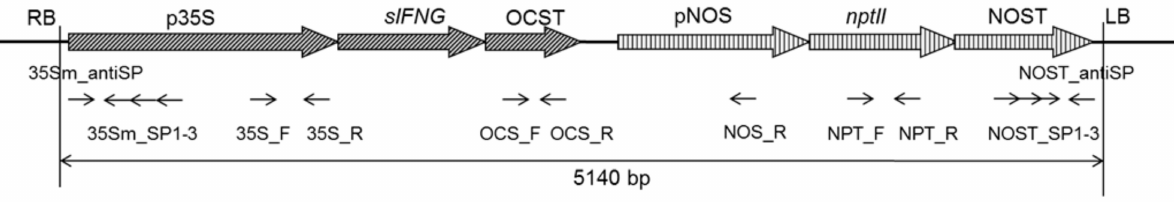
Figure 3. The structure of T-DNA from plasmid pART27-INT6 and primers binding sites. p35S—35S promoter; sIFNG—synthetic bovine gamma interferon gene; OCST—octopine synthase termina- tor; pNOS—nopaline synthase promoter; nptII—neomycin phosphotransferase II gene (kanamycin resistance); NOST—nopaline synthase